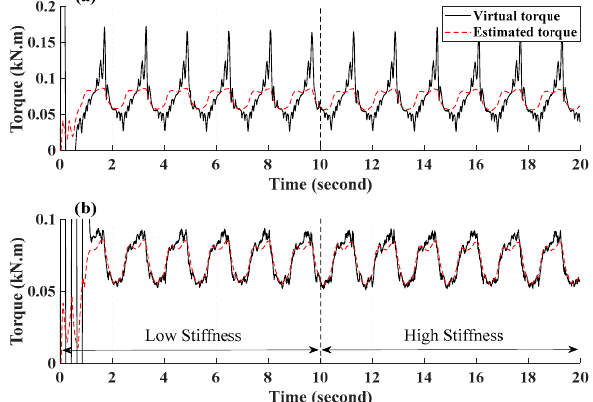
Figure 9. The torque responses of ( a ) CBSMC; ( b ) the proposed ABSMC.